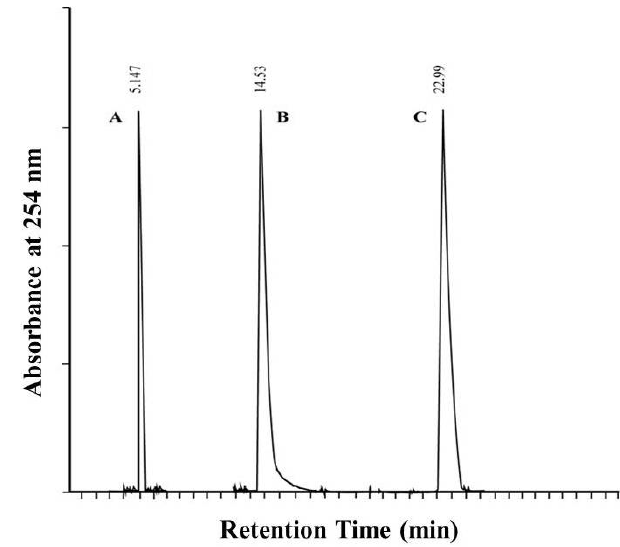
Fig 2 . High-performance liquid chromatogram acquired at 254 nm of A: purified fumarprotocetraric acid (FUM) (R 5.14 min); B: T purified usnic acid (USN) (R 14.93 min); C: purified barbatic acid T (BAR) (R 22.99 min). T